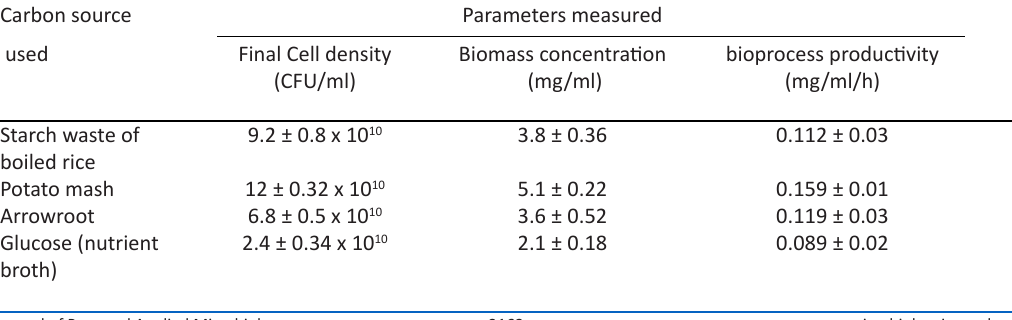
Table 2. Bioprocess efficiency parameters of different media used in batch fermentation of biofertilizer production Carbon source